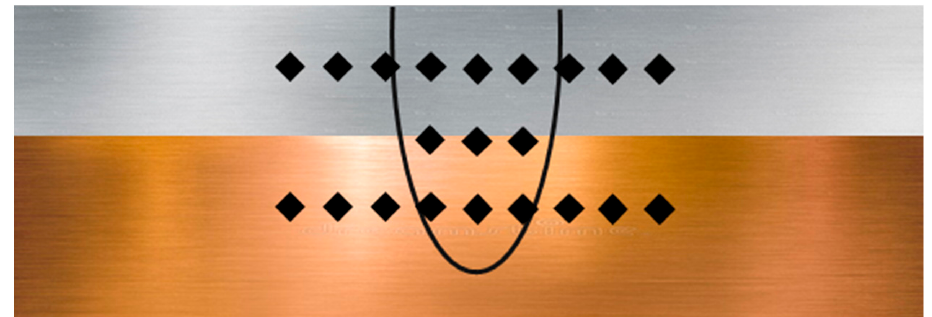
Figure 5. Vickers microhardness indentation positions.